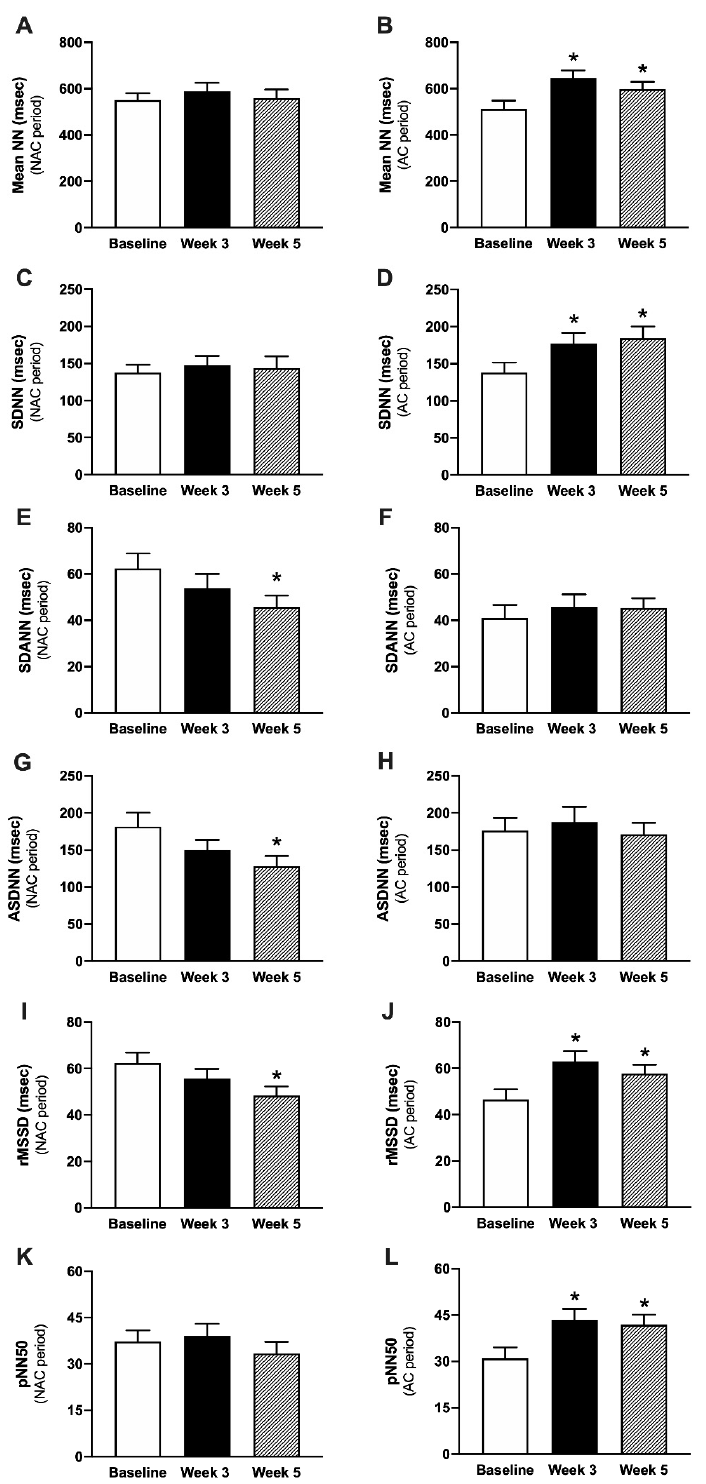
Figure 1. Time-domain parameters of HRV in the NAC ( A , C , E , G , I , K ) and AC ( B , D , F , H , J , L ) period. Abbreviations: NAC period = no acupuncture treatment period, AC period = acupuncture treatment period, mean NN = average NN intervals, SDNN = standard deviation of all NN intervals, SDANN = standard deviation of the averages of NN intervals in 5 - min, ASDNN = average standard deviation of all 5 - min R - R intervals, rMSSD = root mean square of the sum of the squares of differences between adjacent NN intervals, pNN50 = percentage of successive NN intervals > 50 msec, * p < 0 . 05 comparison with the baseline .